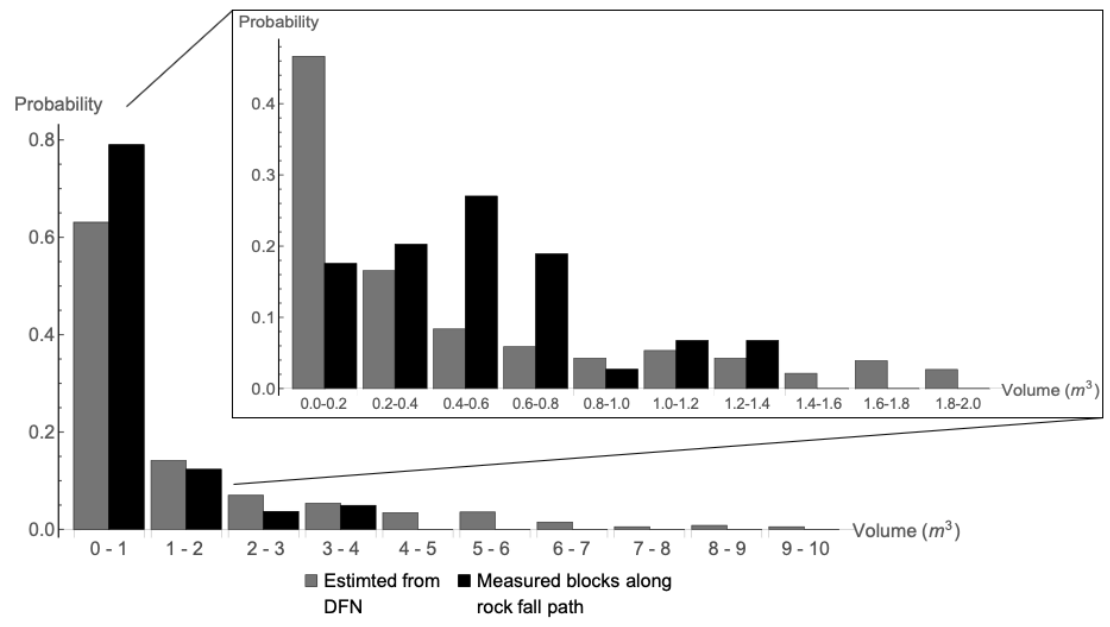
Figure 6. Fragmented rockfall volume distribution as calculated by the persistent DFN method and field surveys. Modeled after the work in [35].